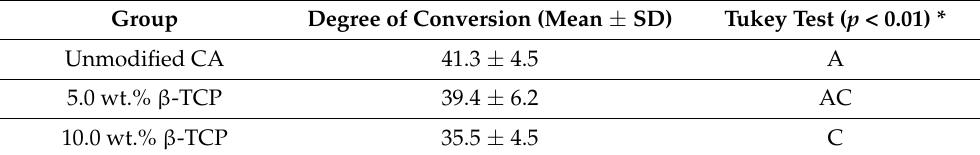
Figure 4. FTIR spectra of polymerized and unpolymerized groups from unmodified and BTCP nanocrystal-modified adhesive. The degree of conversion was calculated by estimating the changes in peak height ratio of the absorbance intensities of aliphatic C=C peak at 1638 cm − 1 and that of an internal standard peak of aromatic C=C at 1608 cm − 1 during polymerization, in relation to the uncured adhesive as indicated with the box. Table 2. Degree of conversion (DC) displayed by CA, β -TCP 5%, and β -TCP 10% adhesive.